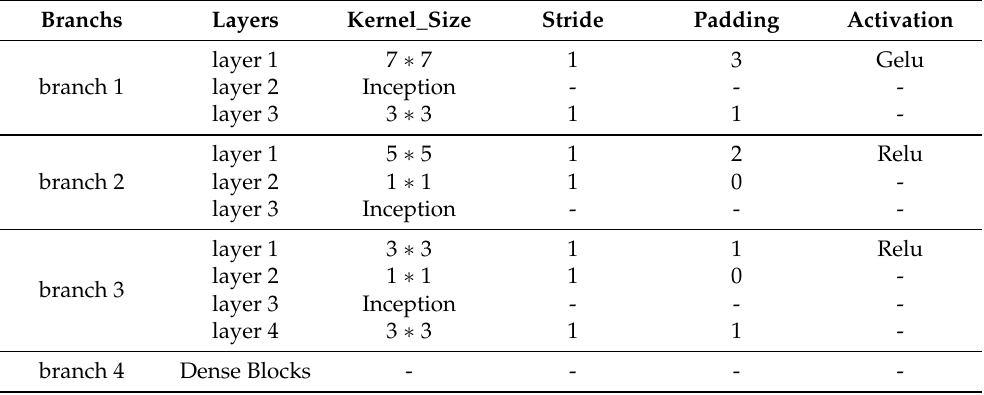
Table 1. The Encoder Architecture of Network.